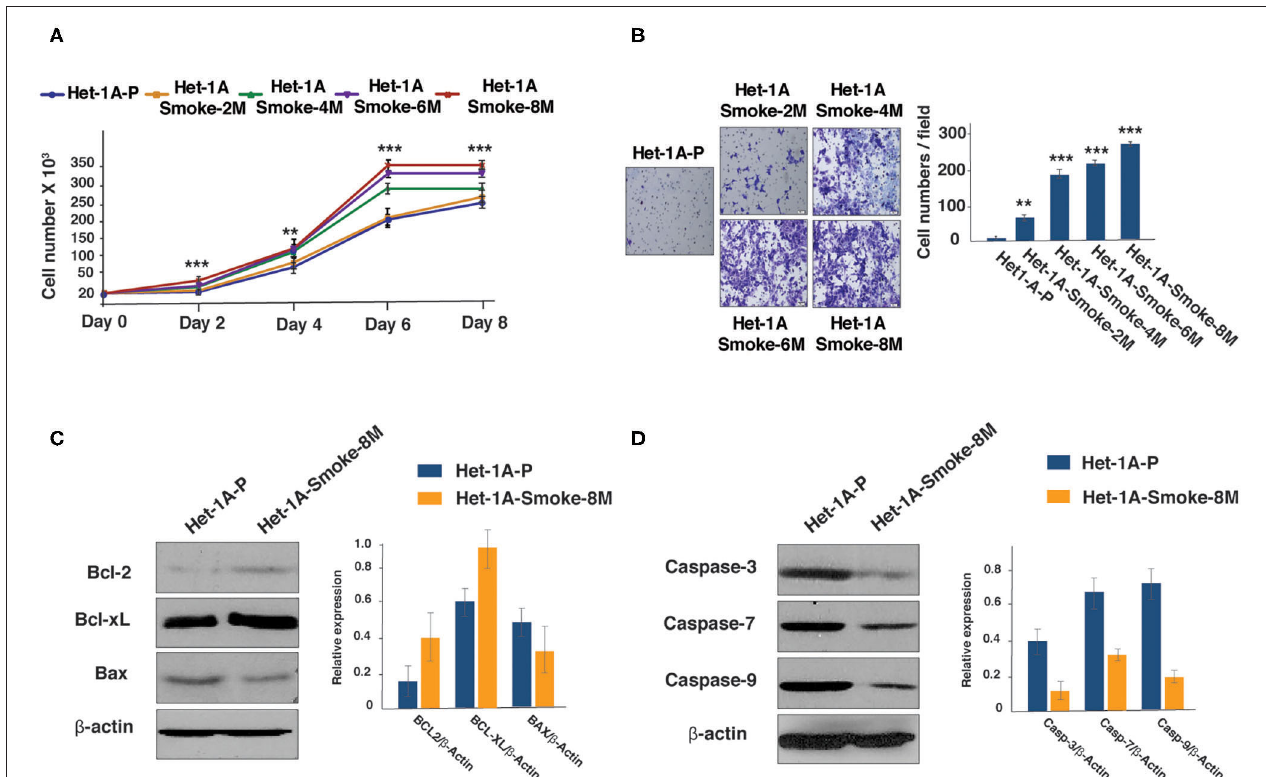
FIGURE 1 | Chronic exposure to CSC treatment increases proliferative and invasive ability of esophageal cells. (A) Growth curve depicting cellular proliferation rates of Het-1A-Parental and Het-1A-Smoke (2M, 4M, 6M, and 8M) cells (*** p < 0.0001, ** p < 0.01). (B) Invasion assays were carried out using Het-1A-Parental, Het-1A-Smoke-2M, Het-1A-Smoke-4M, Het-1A-Smoke-6M, and Het-1A-Smoke-8M cells. Representative images were photographed for each time point at 10 × magnification. Graphical representation of invasive ability of indicated cells (*** p < 0.0001, ** p < 0.01). (C) Western blot analysis of Bcl2, Bcl-xL and Bax